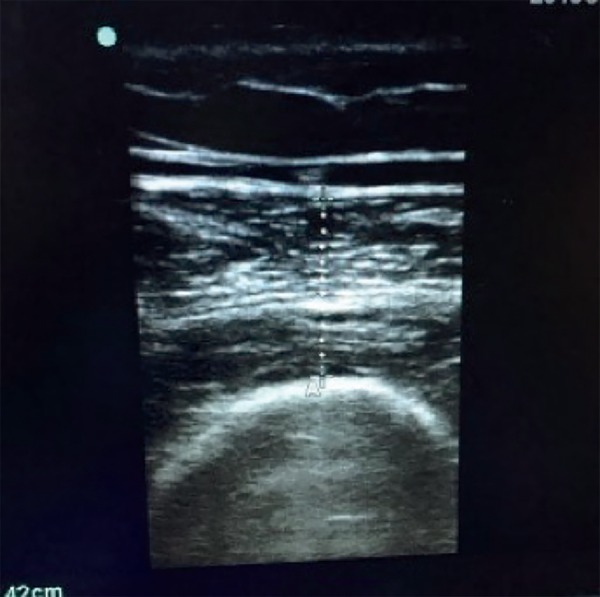
Quantification of muscle thickness.